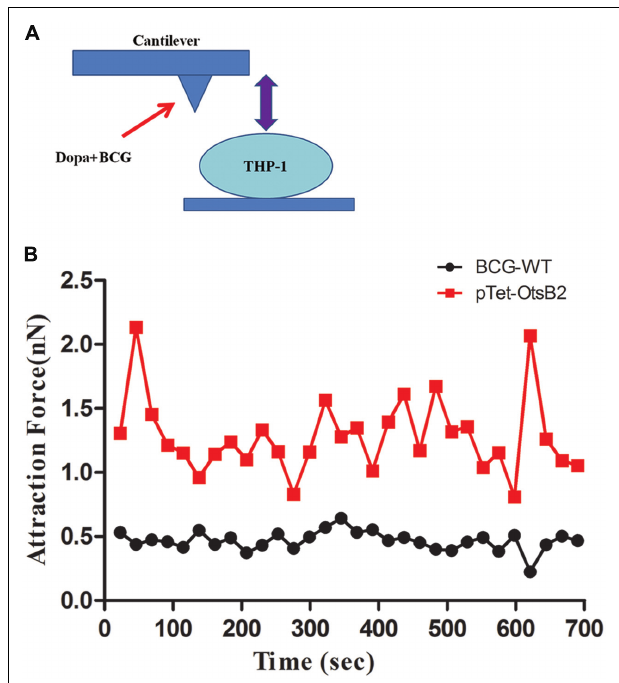
FIGURE 3 | BCG-OtsB2 has stronger binding interactions to THP-1 macrophages as measured by AFM. (A) cartoon schematic of AFM measurements. (B) Binding force data for WT BCG (black) and BCG-OtsB2 (red) and THP-1 macrophages. Results representative of three